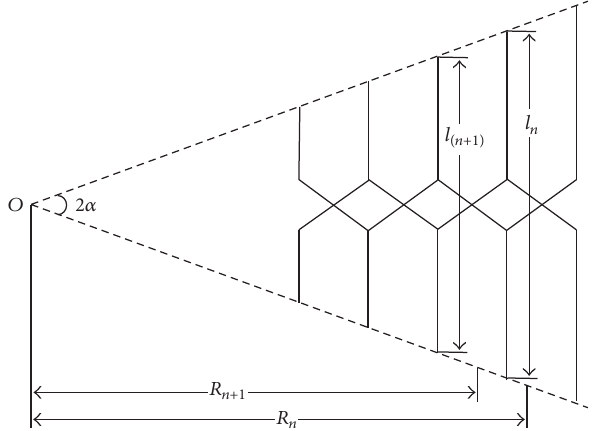
Figure 3: Log periodic dipole